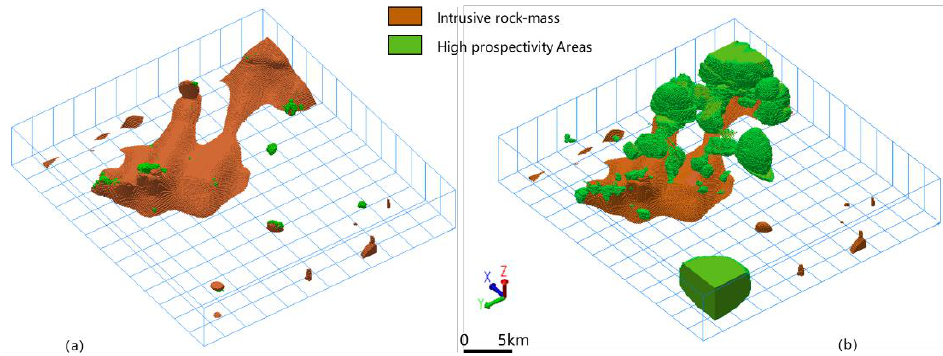
Figure 8. Distribution map of favorable areas, ( a ) Random forest model results; ( b ) Logistic regression model results.